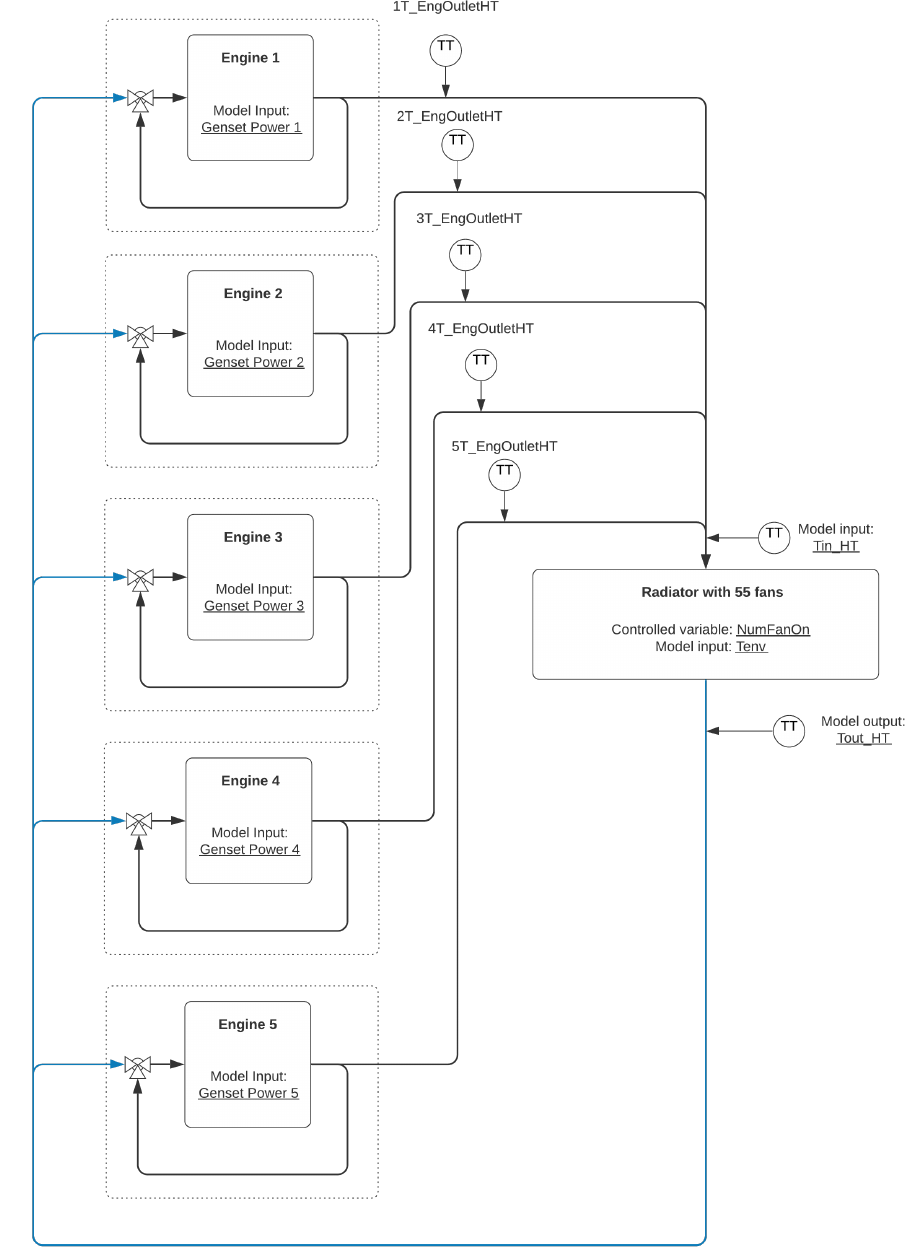
Figure 1. Water cooling